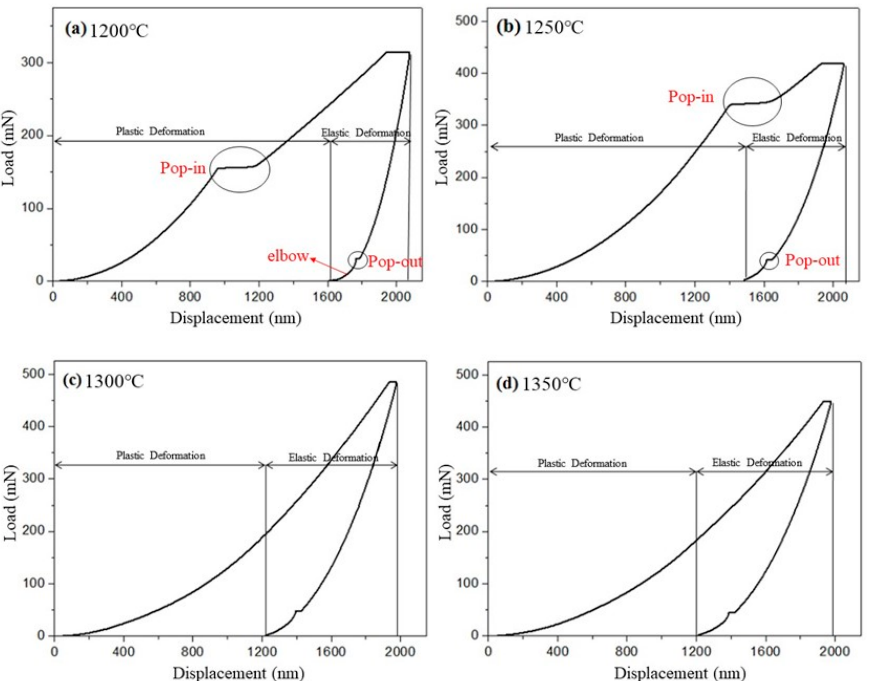
Figure 10. Load-deformation curves of CVD HfO 2 coatings prepared at different temperatures. ( a ) 1200 °C; ( b ) 1250 °C; ( c ) 1300 °C; ( d ) 1350 °C.